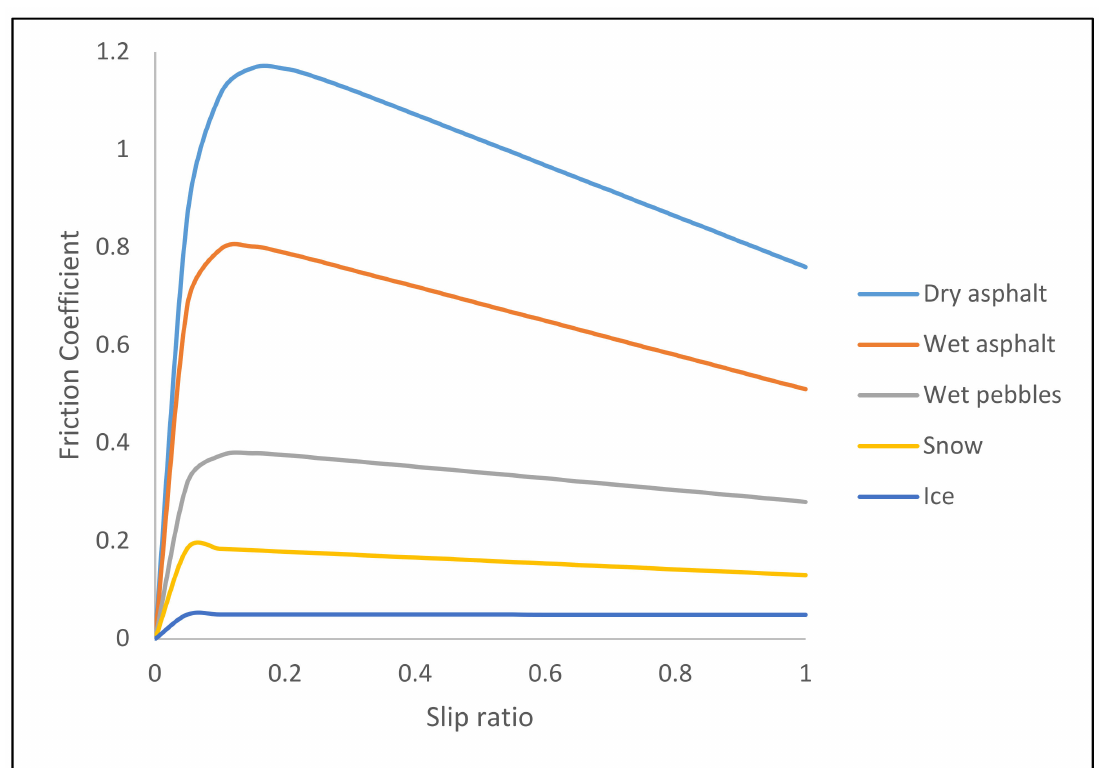
Figure 3. Slip ratio versus friction